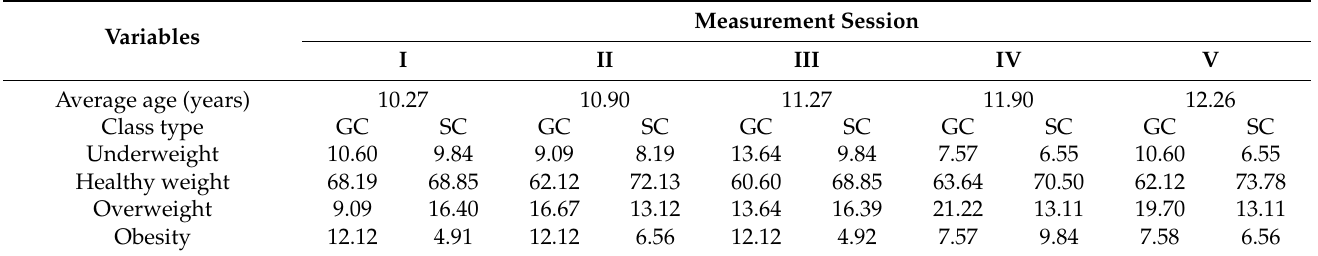
Table 3. The percentage of body mass categories in the GC and SC boys during the course of the study.